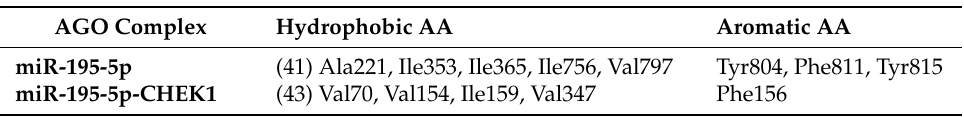
Table 5. Amino acid residues of the binding pocket of the receptor protein involved in the molecular interaction with miR-195-5p and miR-195-5p-CHEK1 duplex (2.0 Å). AGO